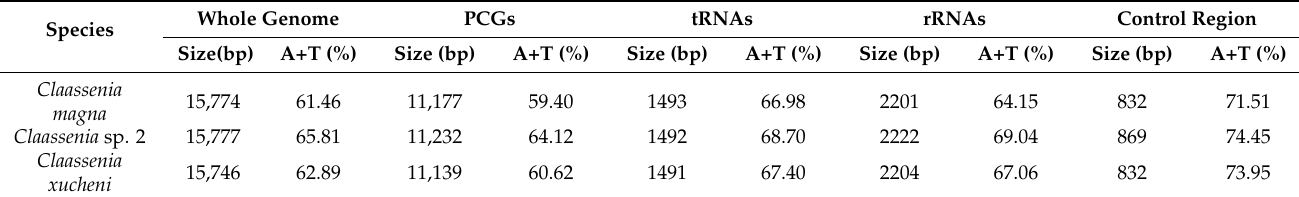
Table 2. A+T content in different regions of C. magna , Claassenia sp. 2 and C. xucheni mitogenome. Whole Genome PCGs tRNAs rRNAs Control Species